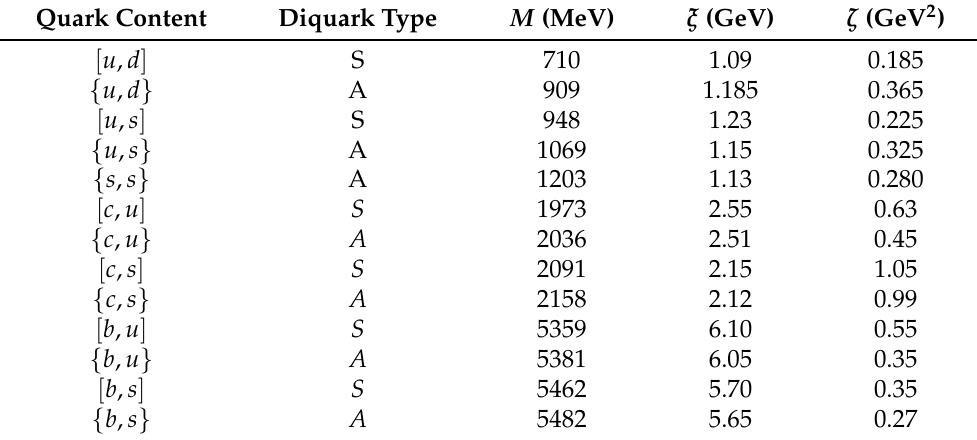
Table 2. Masses M and form factor parameters of light and heavy–light diquarks. S and A denote scalar and axial vector diquarks, which are antisymmetric [ · · · ] and symmetric {· · · } in flavour, respectively.